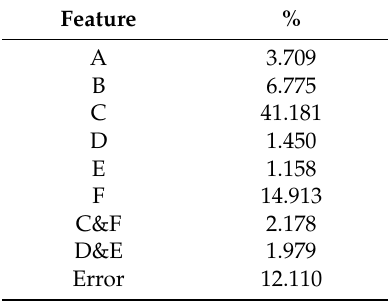
Table 6. Error reported by the ANOVA analysis and relative influence of the election of the input features on the global result when the Decision Tree algorithm is applied. Inputs: A = µ SMV ,